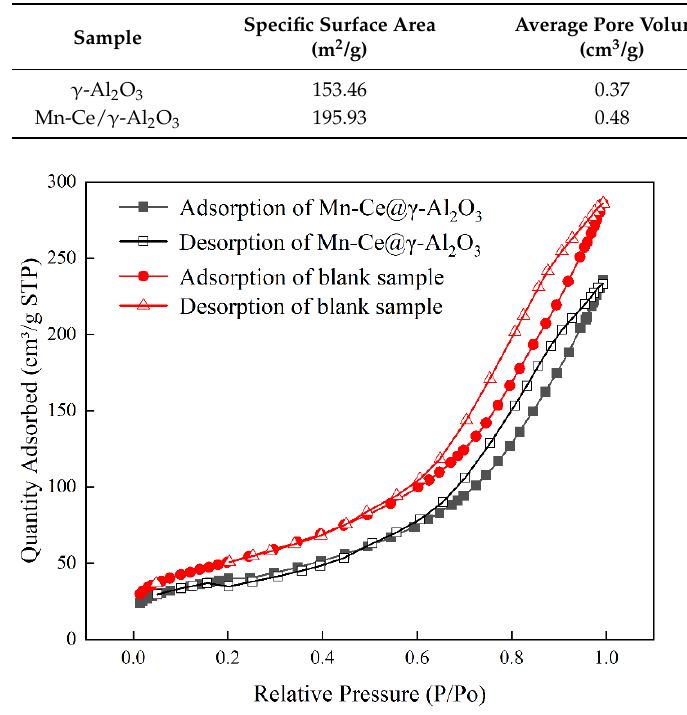
Table 3. BET characterization analysis of Mn-Ce/ γ -Al 2 O 3 catalyst.